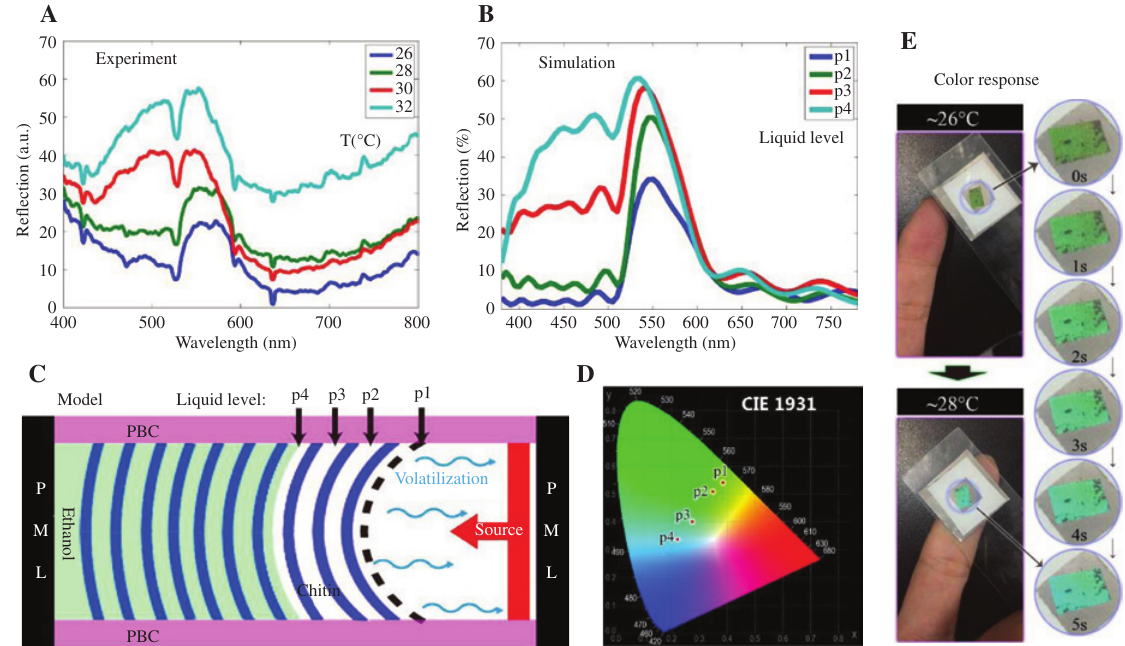
Figure 3: Thermochromic property of sealed PC wing sample with different temperatures. (A, B) Experiment and simulation reflectance under different temperatures (26 ° C, 28 ° C, 30 ° C and 32 ° C). (C) Structure model and boundary conditions. The boundary conditions in horizontal direction are absorbing (perfectly matched layer, PML) and in vertical direction are periodic (periodic boundary condition, PBC). A plane wave source illuminates the structure. Different liquid levels (p1, p2, p3, and p4) are used to characterize the increase of the tem- perature with the volatilization of the ethanol. (D) Color change calculated from corresponding reflectance in CIE chromaticity diagram with different temperatures. (E) Color response with different temperatures changed by contacting a finger, contact time is from 0 s to 5 s.